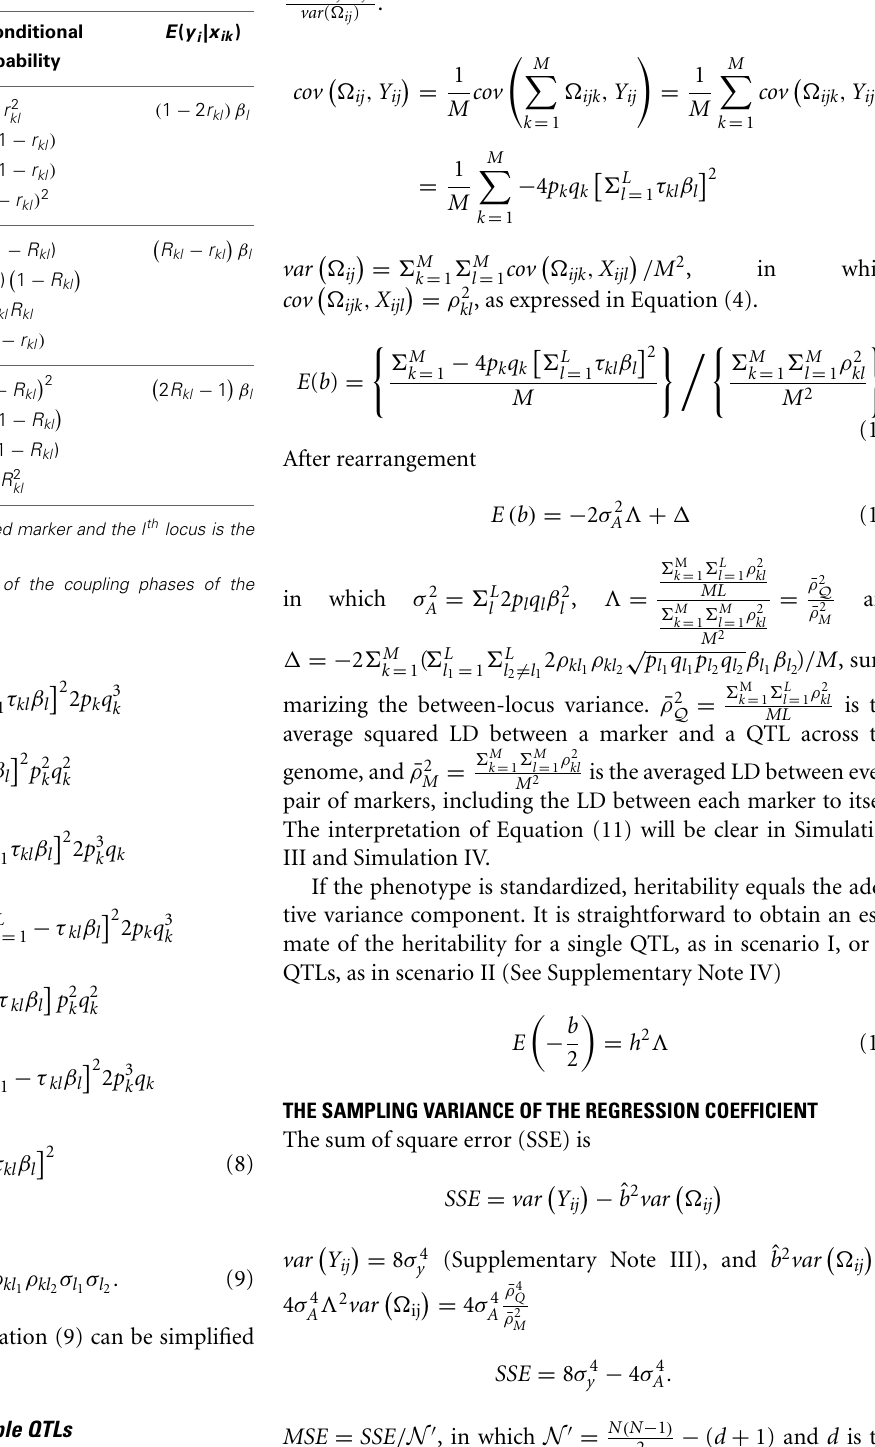
Table 4 | The expected phenotype conditional to one’s genotype on the observed